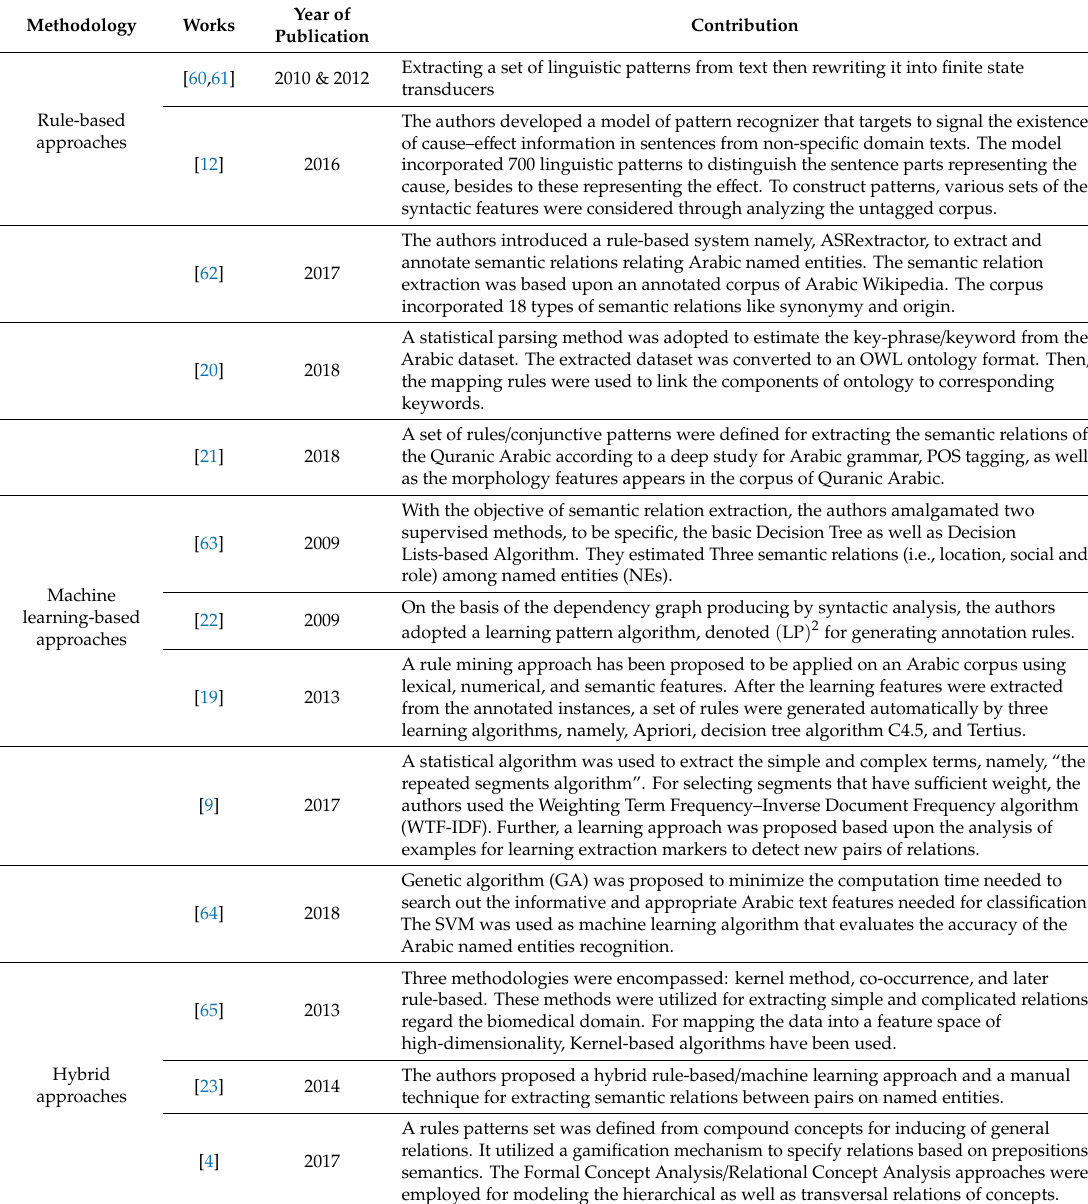
Table 2. A state-of-the-art on Arabic ontology